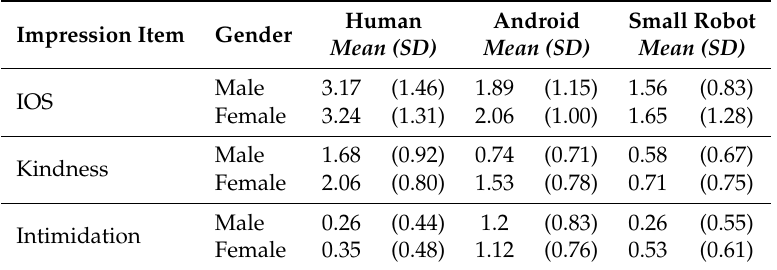
Table 3. Participants’ impression of the